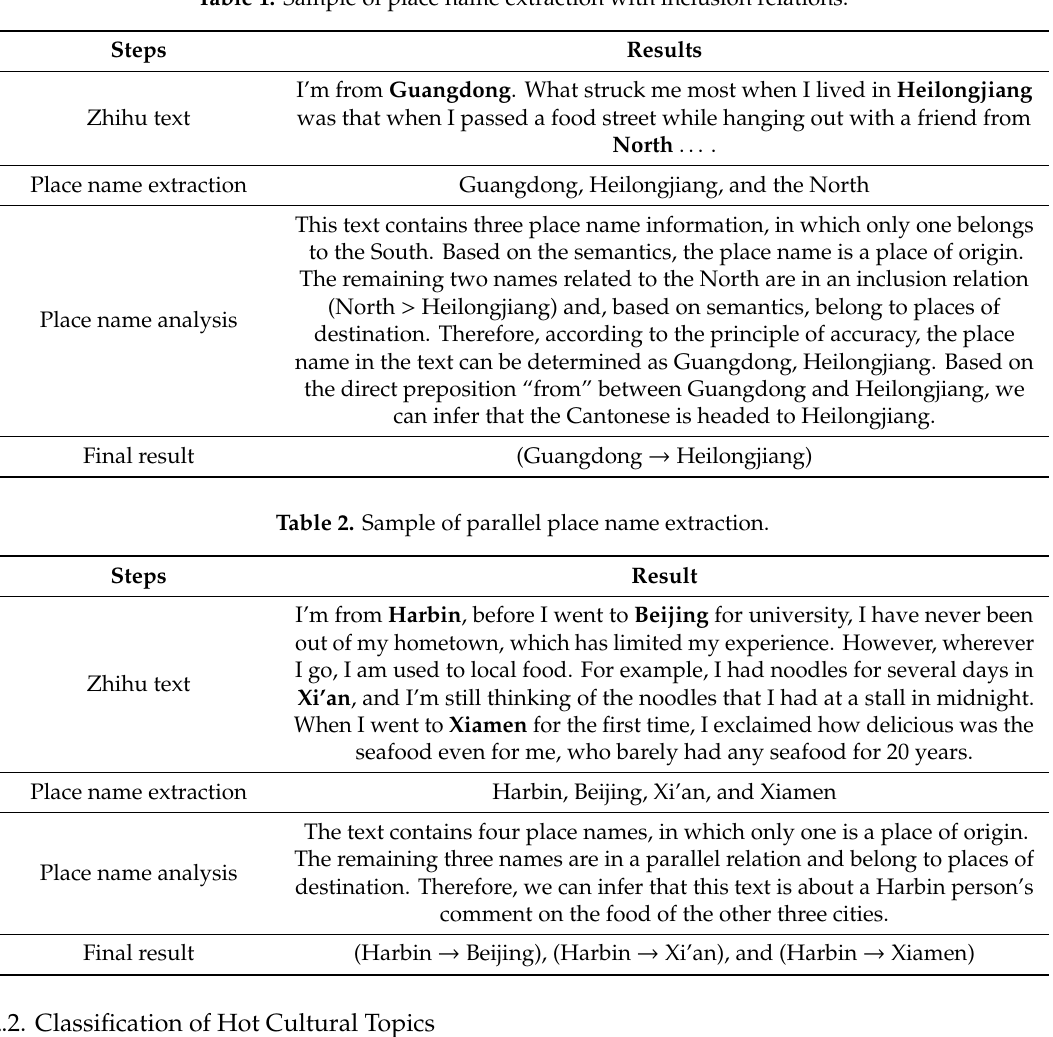
Table 1. Sample of place name extraction with inclusion relations.